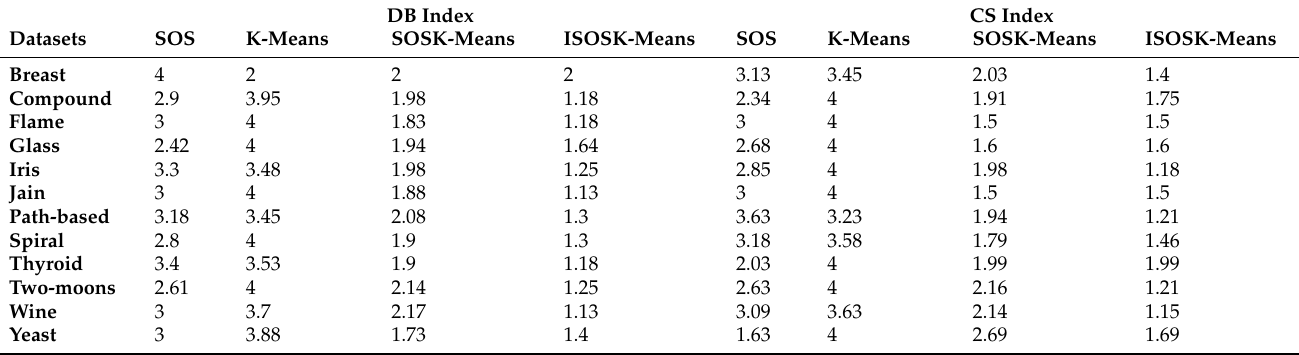
Table 11. Friedman mean rank for ISOSK-means, SOSK-means, SOS, and K-means. DB